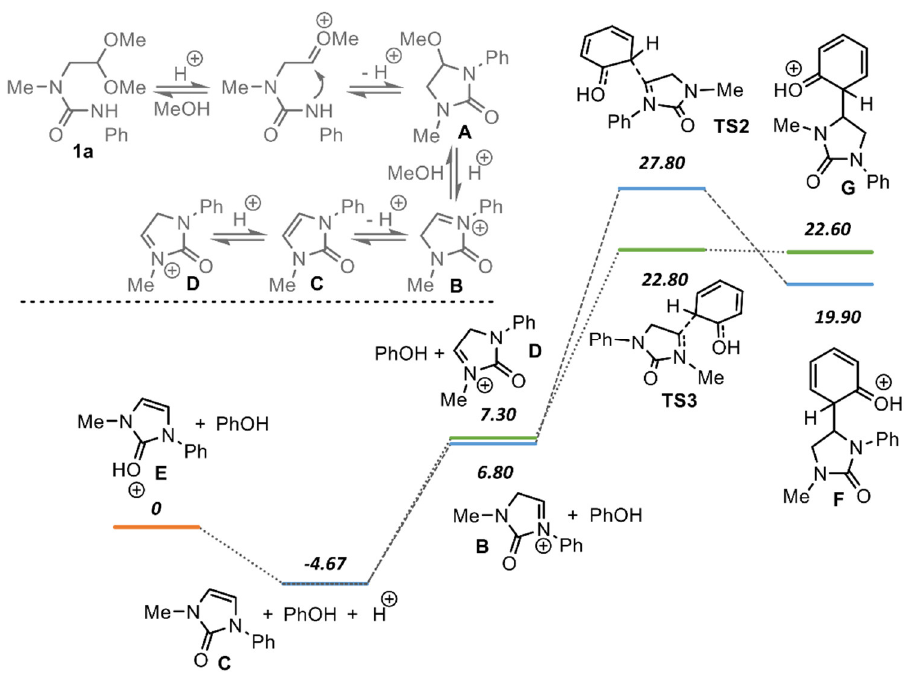
Scheme 4. Plausible mechanism for the formation of regioisomeric imidazolidin-2-ones and